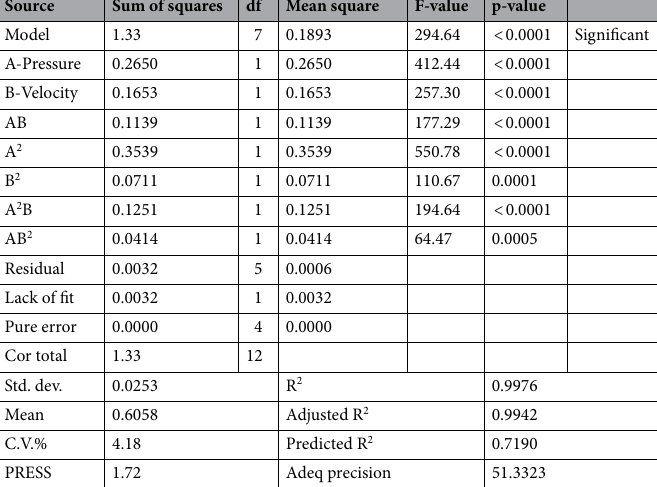
Table 6. ANOVA results of quadratic model (wear rate is response) for hot rolled steel.